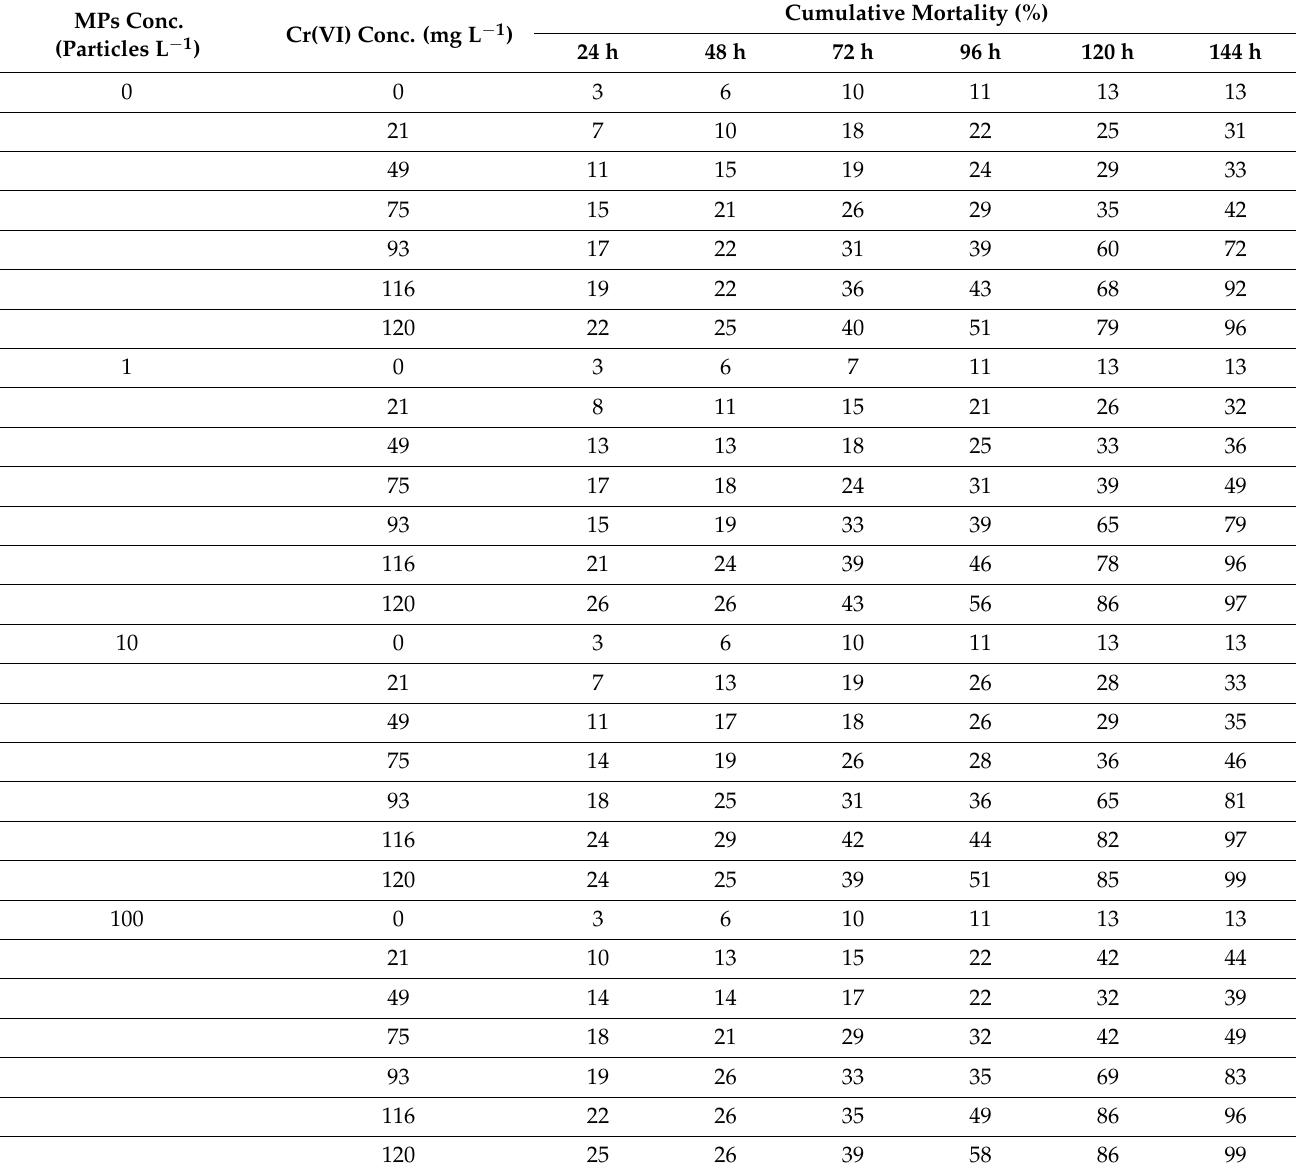
Table 1. Cumulative mortality of zebrafish embryos and larvae measured in response to different concentrations of Cr(VI) with 1 µ m MPs (1, 10, and 100 particles L − 1 ) for 144 h. MPs